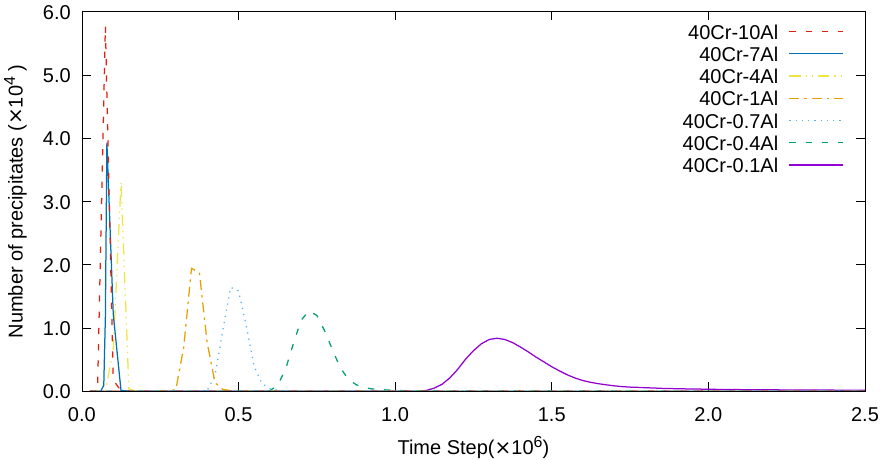
Figure 16. Numbers of α (cid:48) precipitates of the 3D simulation when the initial Cr concentration was 40% at various interval of Al concentration: when the initial Al concentration was less than 1% and 11%, and when the interval of Al concentration was 0.3% and 3%.